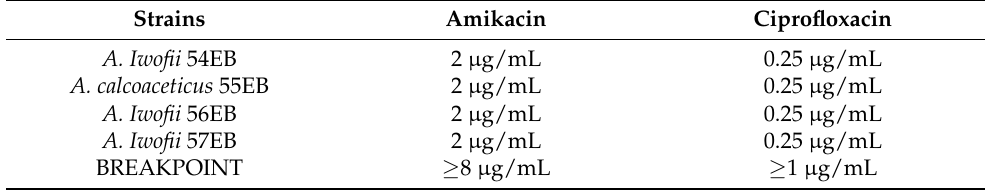
Table 6. MIC values for Acinetobacter and Citrobacter strains and Break Point values.